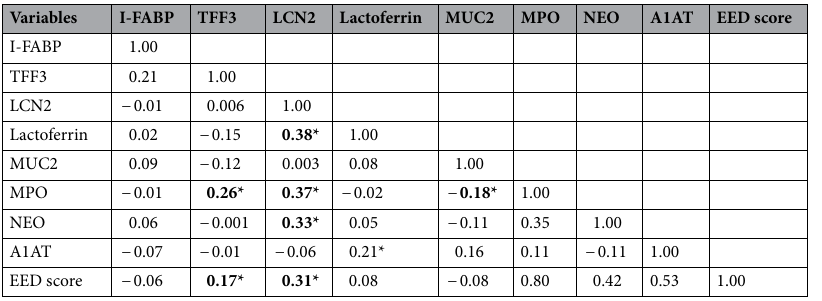
Table 3. Correlation among different biomarkers. * Statistically significant. Significant values are in bold.